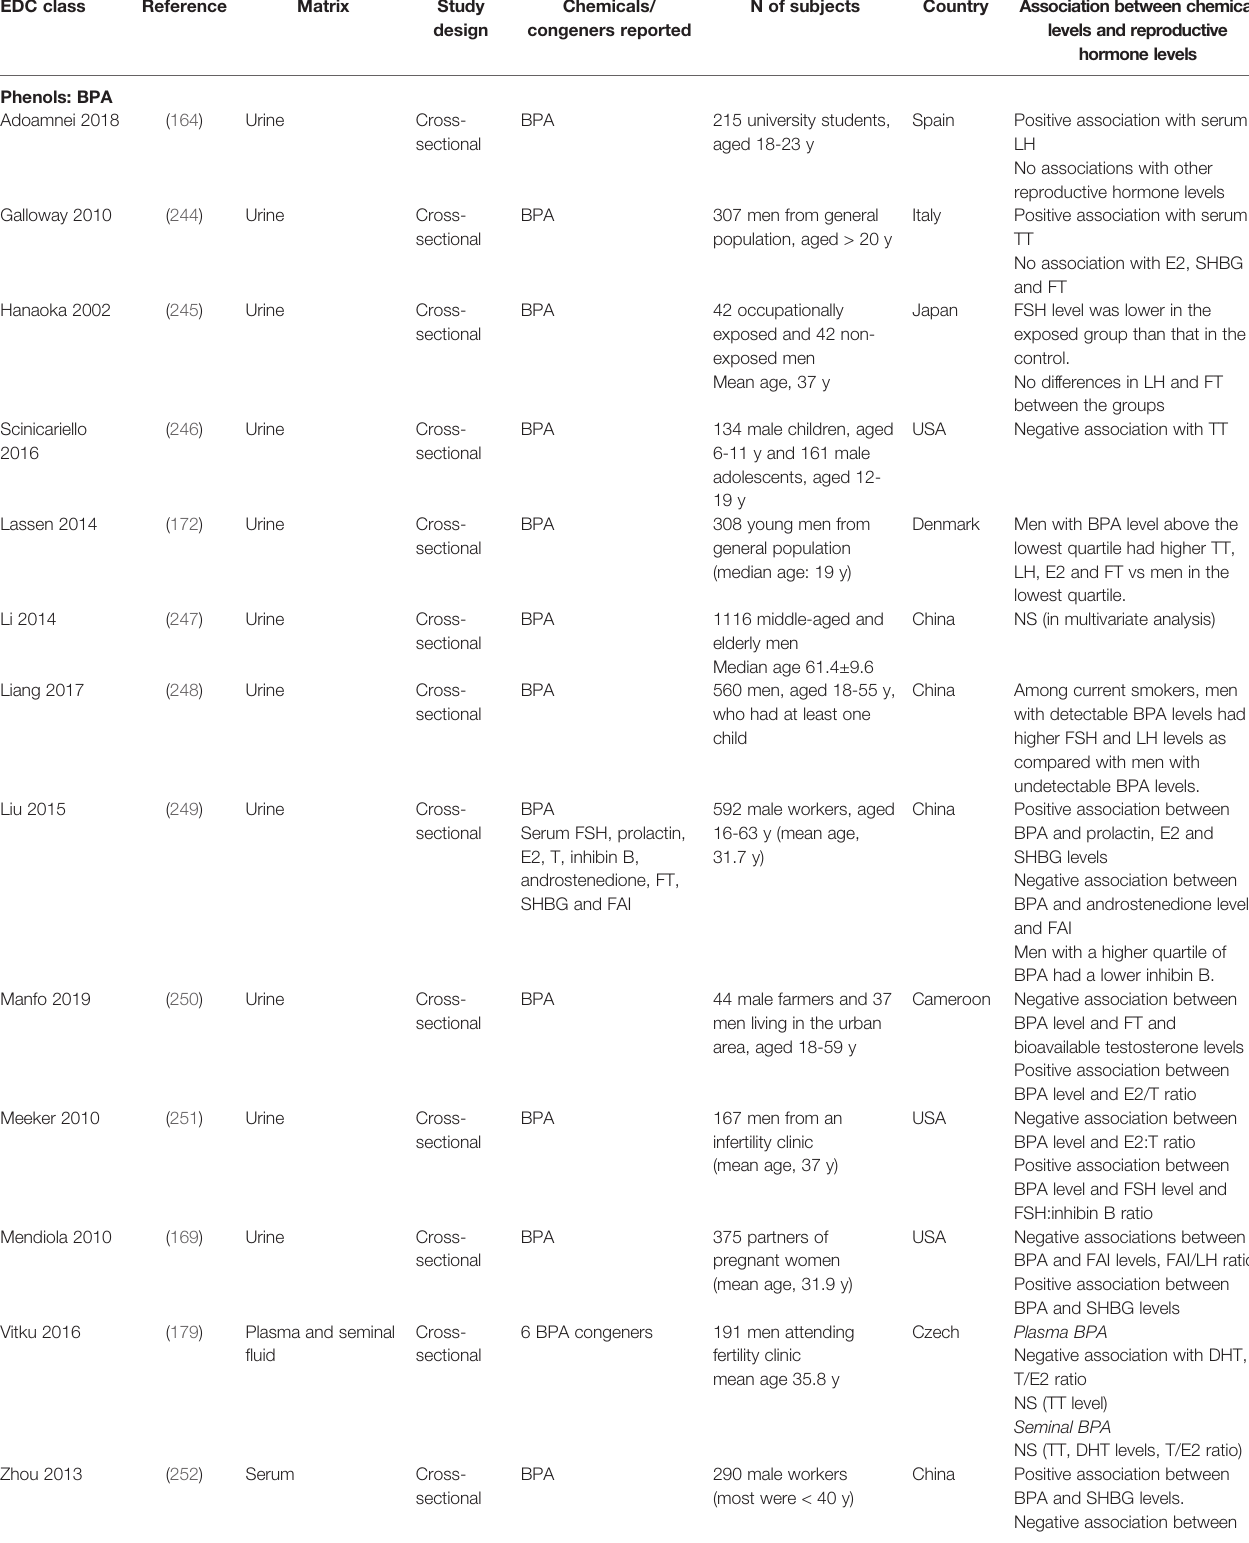
TABLE 7 | Summary of studies that evaluated postnatal EDC exposure and adult reproductive hormone